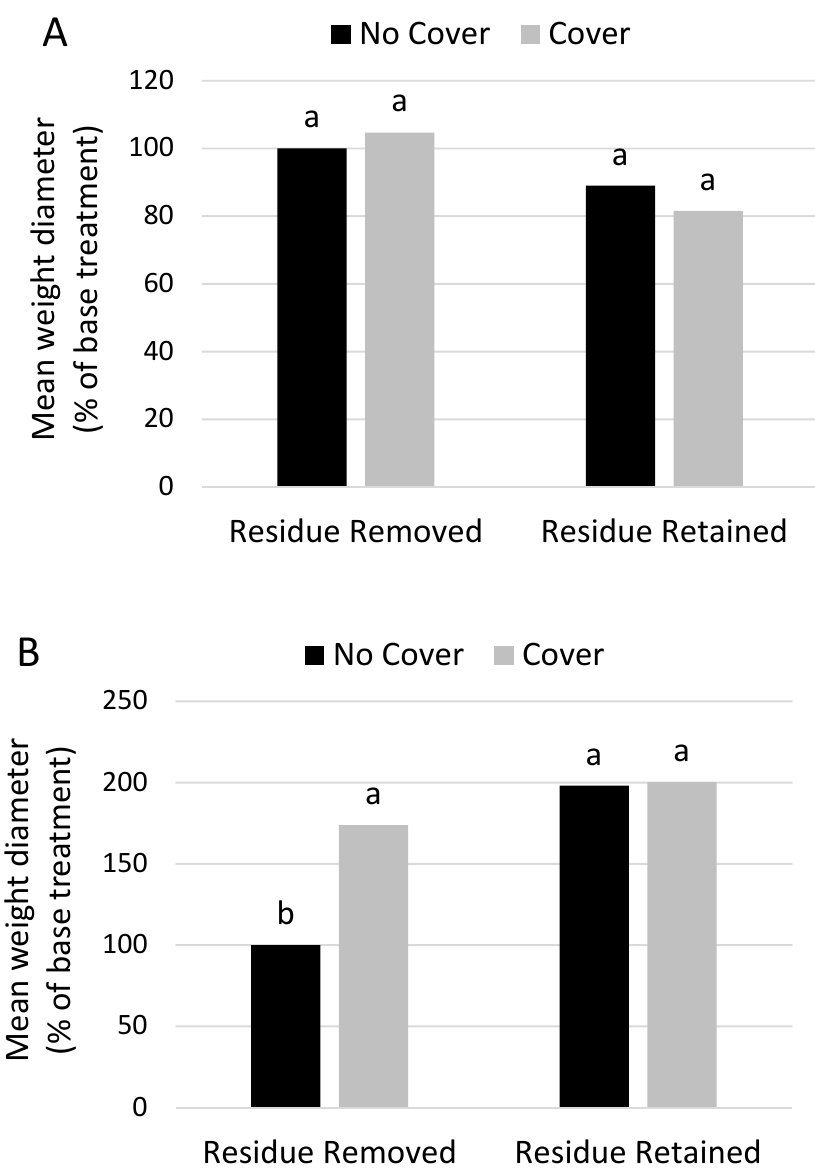
Figure 4. Mean weight diameter of soil aggregates in the 0–5 cm depth interval; values are means ( n = 3) for each treatment expressed a percentage of the mean for the default management treatment with corn residue removal and no cover crop. ( A ) Corn phase. ( B ) Soybean phase. Values marked with the same letter within the aggregate group are not different at α = 0.10, Tukey’s test. Values in this graph are calculated from selected data published in [24] and presented with revised statistics for the selected data.